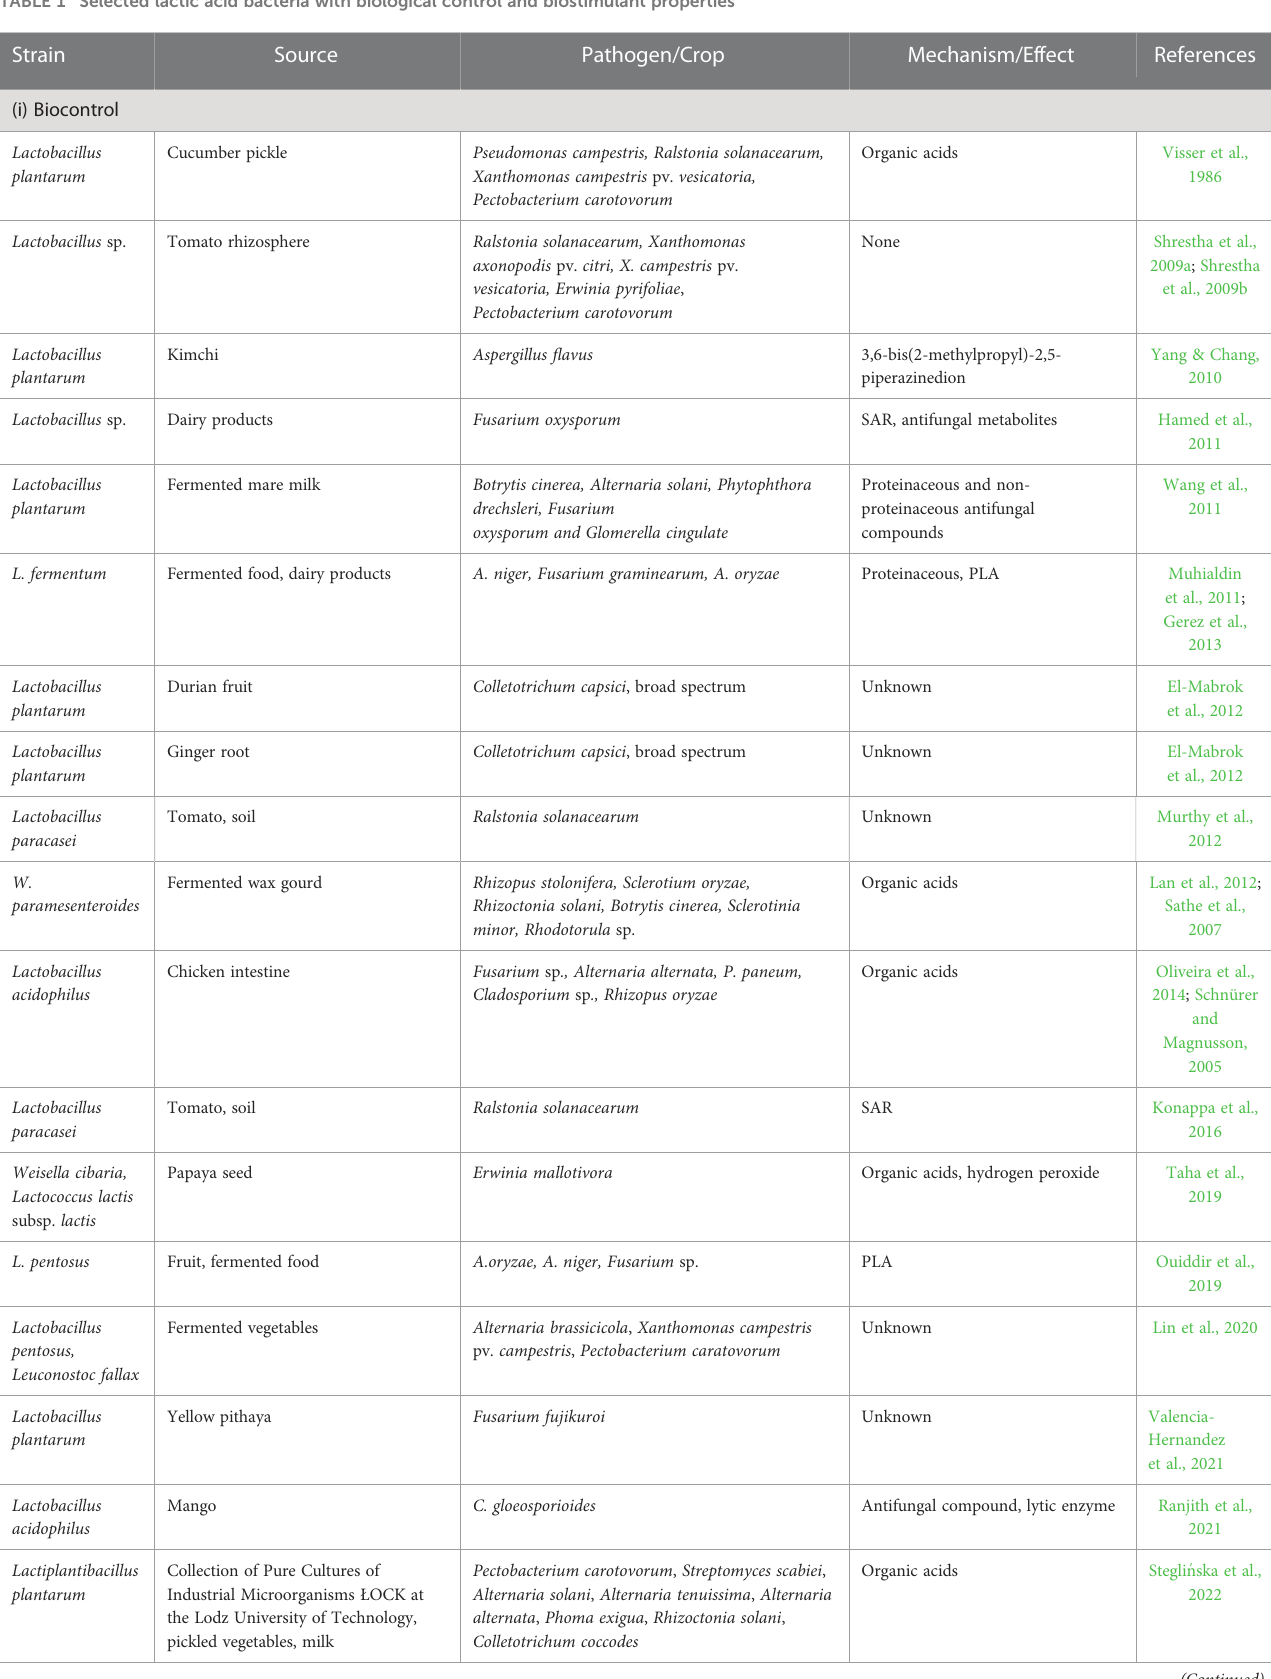
TABLE 1 Selected lactic acid bacteria with biological control and biostimulant properties